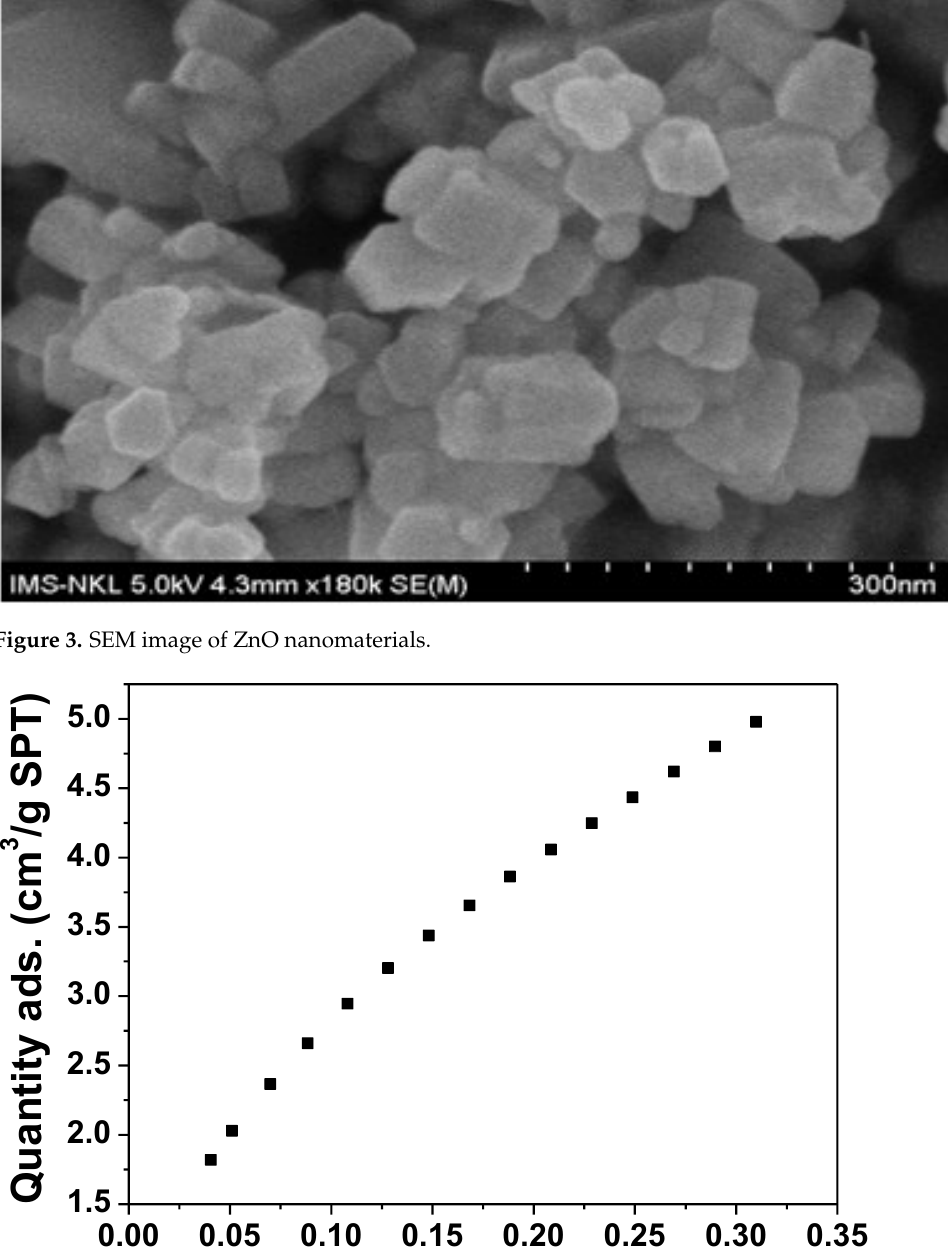
Figure 5. BET plot of as-synthesized ZnO nanorods obtained at a synthesis temperature of 180 °C. 3.2. Structure and Morphology 3.2.1. XRD Analysis The XRD patterns of the ZnO samples are shown in Figure 6, showing the character- istic peaks at (100); (002); (101); (102); (110); (103); (112) and (201). This indicates the wurtz- ite structure of ZnO (plane of the ZnO phase, JCPDS file 36-1451). From the results shown, the diffraction peaks are narrow, sharp and symmetrical, indicating that the samples are well crystalline.